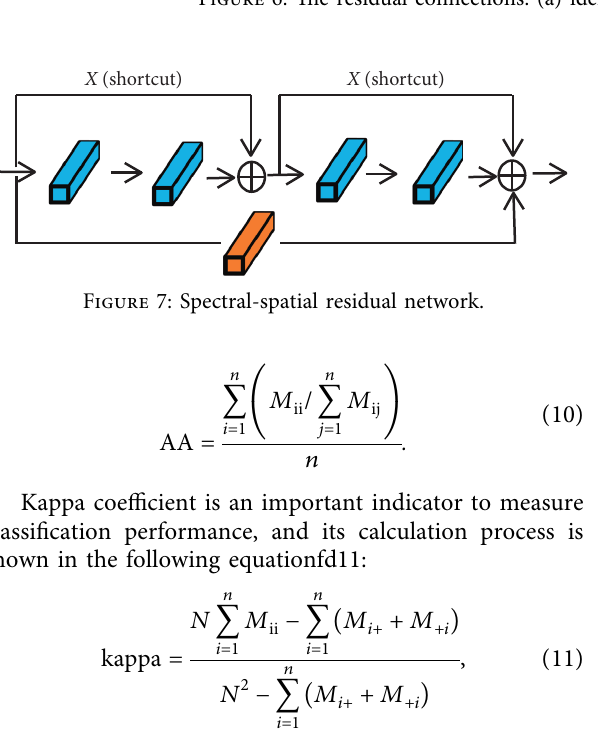
Figure 6: The residual connections: (a) identity connection; (b) nonidentity connection.